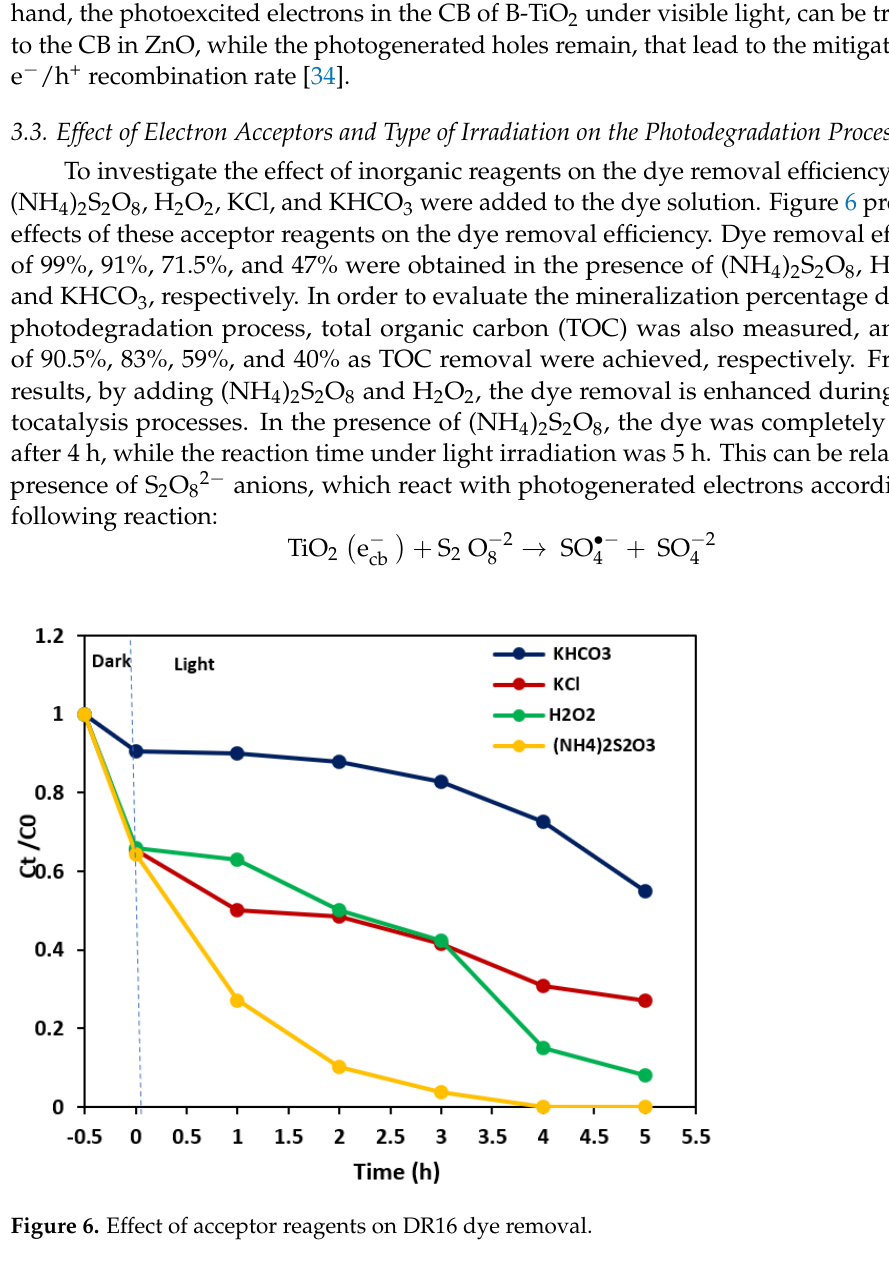
Table 3. Zeta potential value for pure TiO 2 , B-TiO 2 , ZnO/TiO 2, and B-ZnO/TiO 2 measured at room temperature.